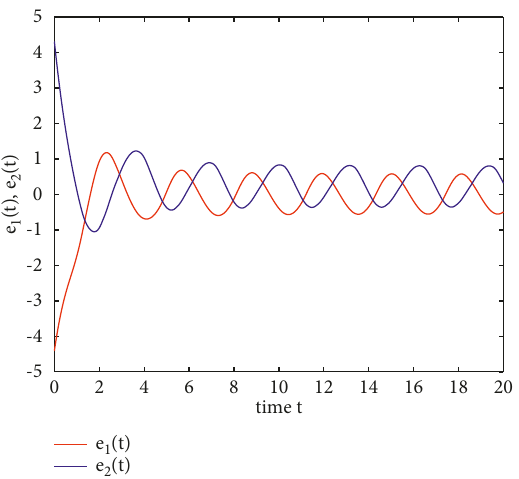
Figure 3: Trajectories of e